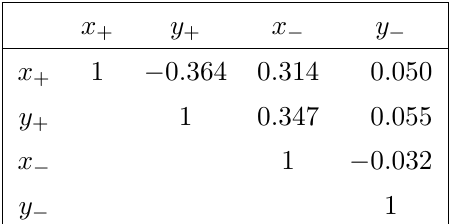
Table 7 . Statistical correlation matrix for ( x + ; y + ; x (cid:0) ; y (cid:0) ) measured from the B (cid:6) ! D(cid:25) (cid:6) data sample.